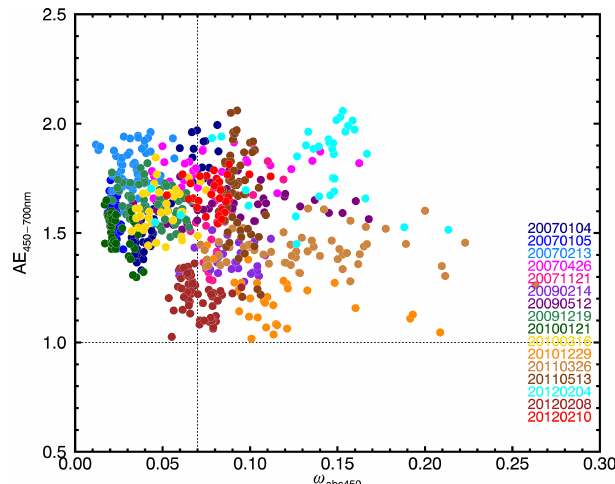
Figure 4. Ångström exponent (AE 450 − 700nm ) and single-scattering co-albedo ω abs450 of all samples (color coded by case). Horizontal dotted line denotes the demarcation of AE 450 − 700nm = 1. Vertical dotted line denotes the demarcation of ω abs450 = 0 .